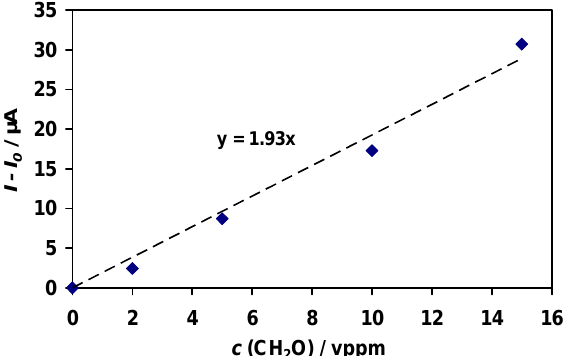
Figure 3. Response curve to formaldehyde (0 - 15 vppm) for the amperometric enzyme- based biosensor. Potential applied: +200 mV vs. Ag/AgCl (3 M KCl); Buffer solution: 0.1 M KCl/KH PO , 5 mM NAD + , pH 8; Enzyme load: 0.5 mg/ 200 µl buffer solution; 2 4